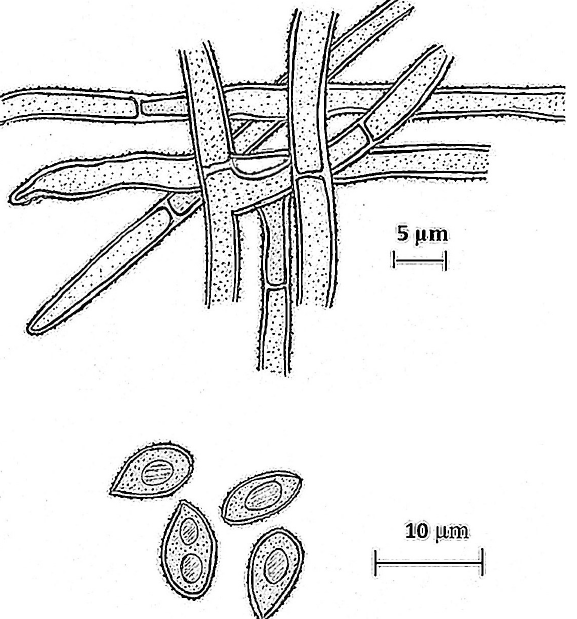
Figure 1. a - Hyphae from tramal region; b -